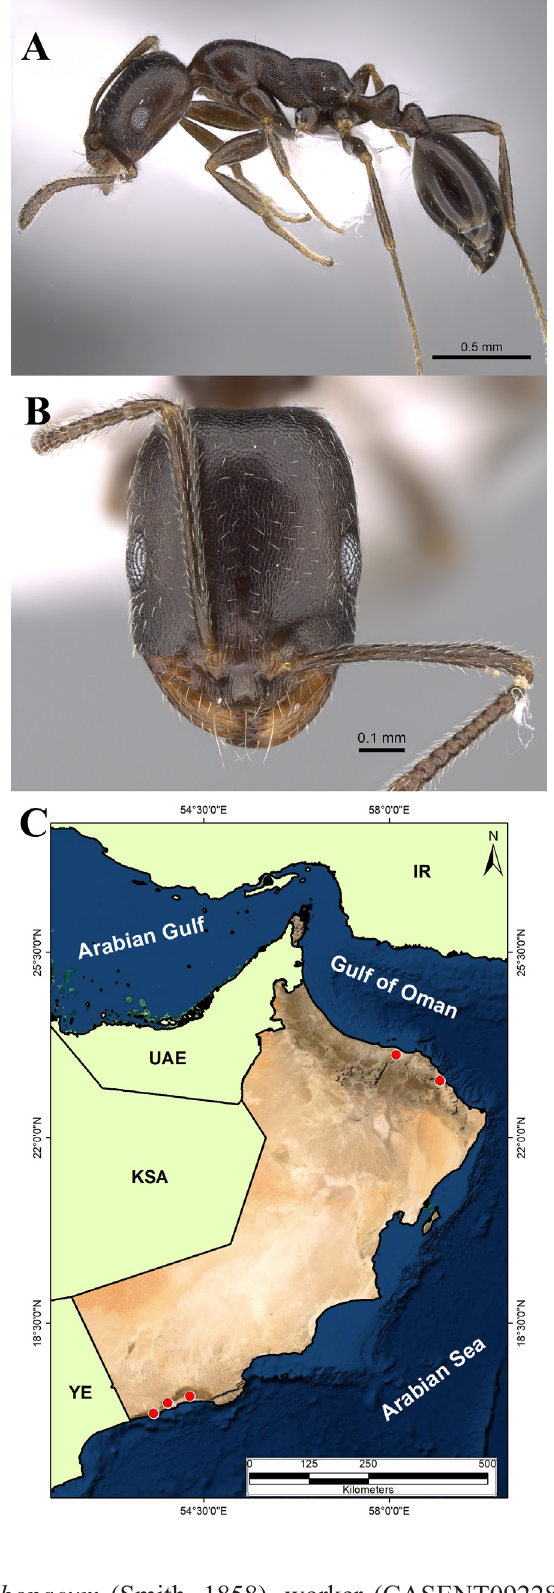
Fig. 42. Monomorium subopacum (Smith, 1858), worker (CASENT0922877, AntWeb.org (Michele Esposito)). A . Body in profile. B . Head in full-face view. C . Distribution